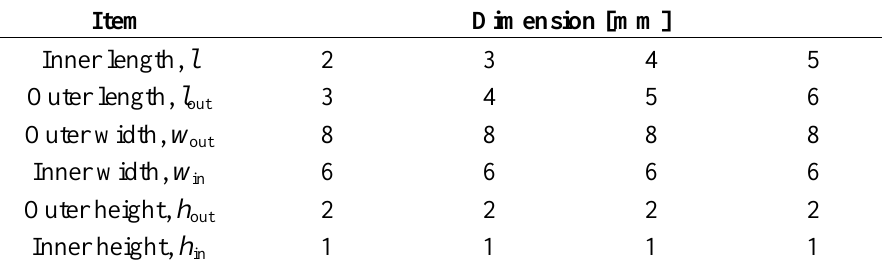
Table 1. Detailed dimensions for the air